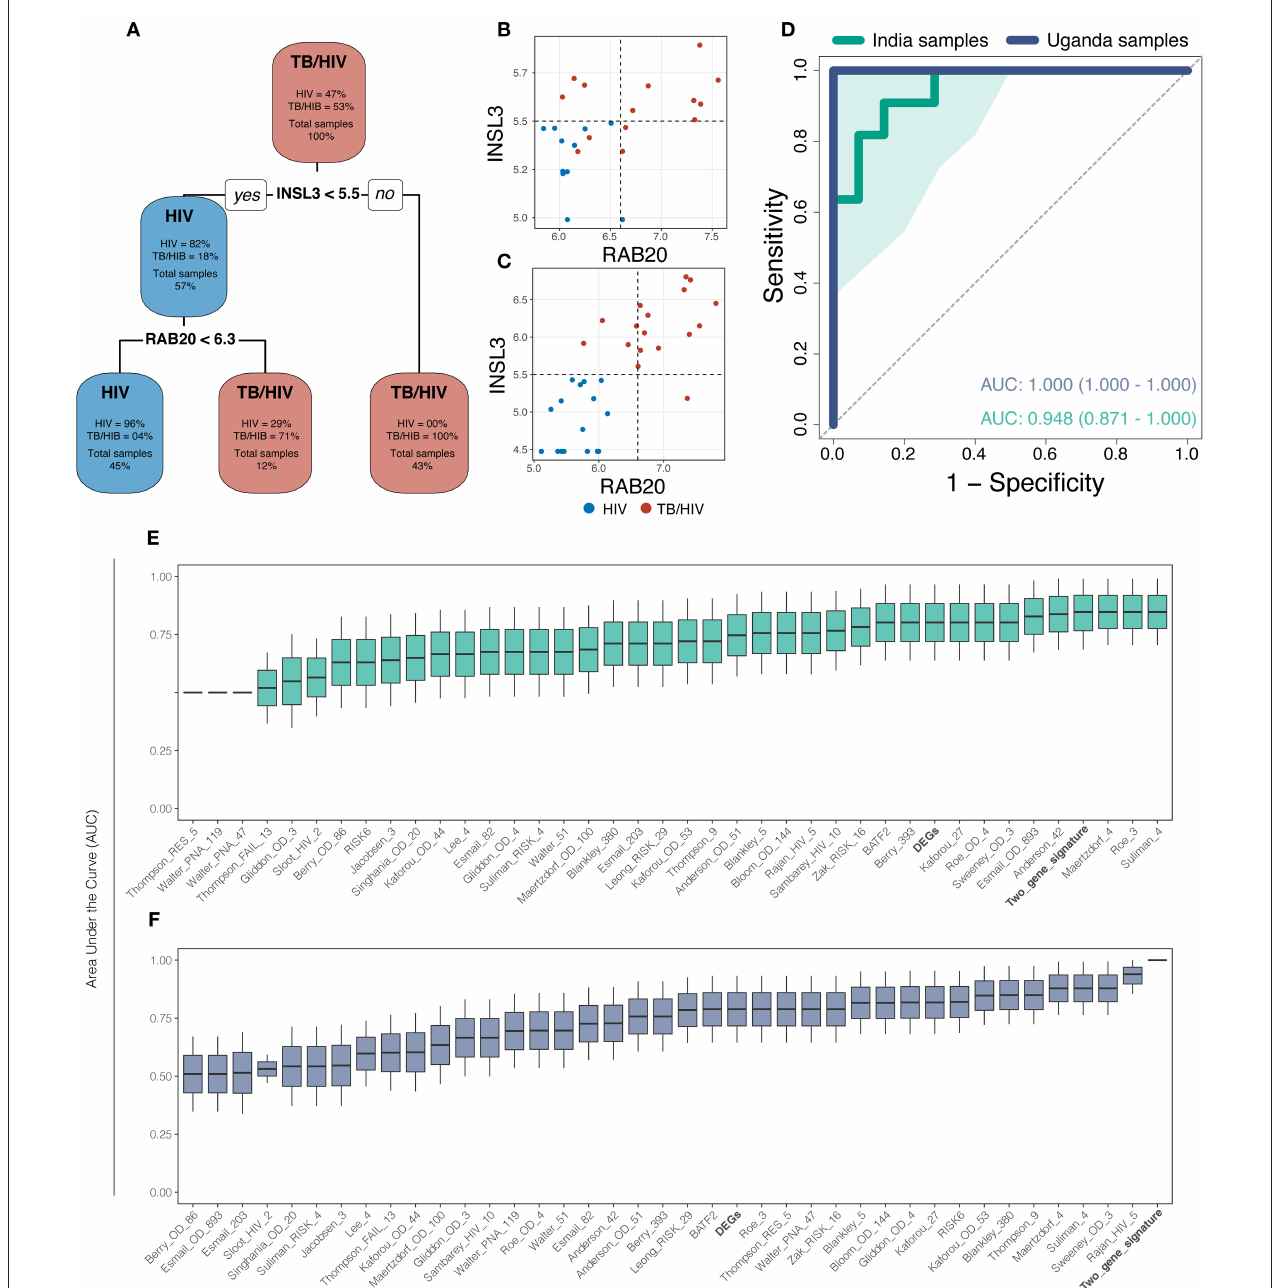
FIGURE 2 | The machine learning approach identified a 2-gene signature (INSL3 and RAB20) that best classified tuberculosis status across study sites. (A) The decision-tree algorithm selected INSL3 and RAB20 genes to classify tuberculosis status among the discovery cohorts. (B,C) Dot plots show that Decision-tree genes correctly classify TB status for most samples from the India cohort (B) and for 100% of samples from the Uganda cohort (C) ; vertical and horizontal dotted lines represent decision thresholds for RAB20 and INSL3 genes, respectively. (D) Receiver operating characteristic (ROC) curve analysis shows strong TB classification performance of Decision-tree genes among samples from India (green line) and Uganda (purple line) with area under the curve (AUC) of 0.948 and 1.00, respectively; shaded area represents standard deviation. Boxplots show the AUC, measured by general linear modeling, for Decision-tree genes (Bold), differentially expressed genes (Bold), and publicly available TB gene expression signatures identifying the Decision-tree genes as the best TB classifier across India (E) and Uganda (F) cohorts.